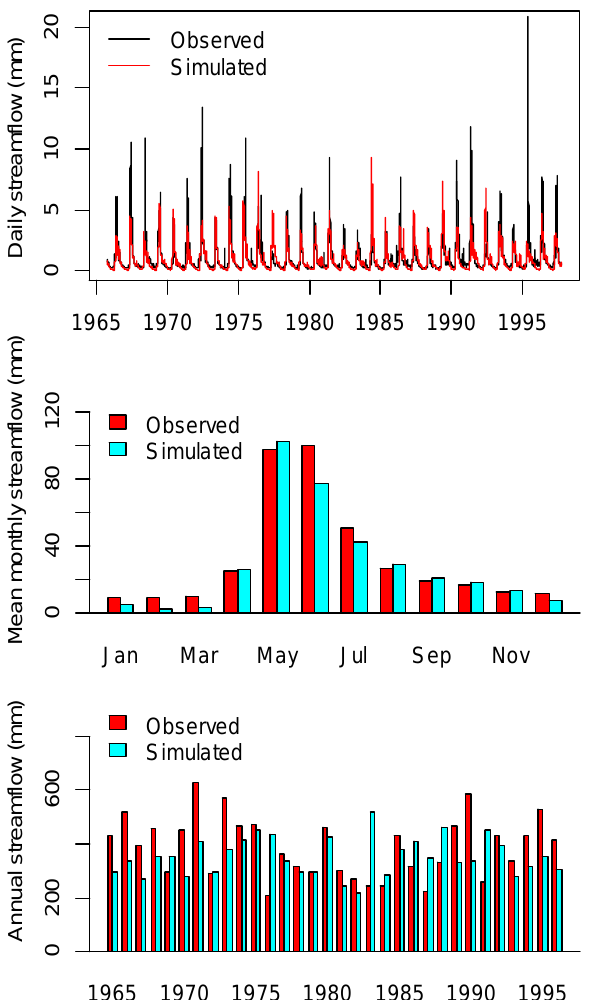
Fig. 6. Same as Fig. 4, but in this case HBV-EC is driven by the LARS-WG-generated daily